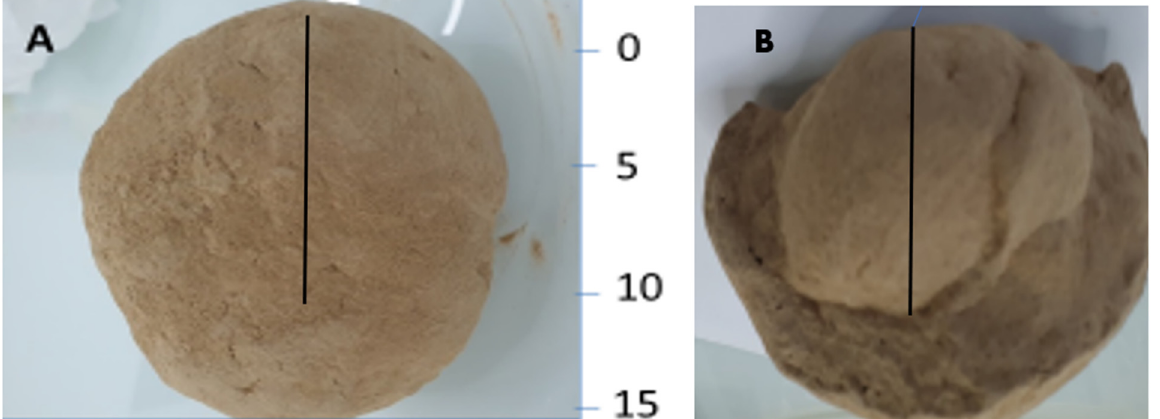
Figure 4. Soil water distribution with the application of 3000 cm 3 of non-evaporative infiltration from subsurface drip irrigation: ( A ) 0.500, ( B ) 1000, ( C ) 2000 cm 3 /hour and ( D ) 3000 (cid:2913)(cid:2923) soil water contents are marked inside).